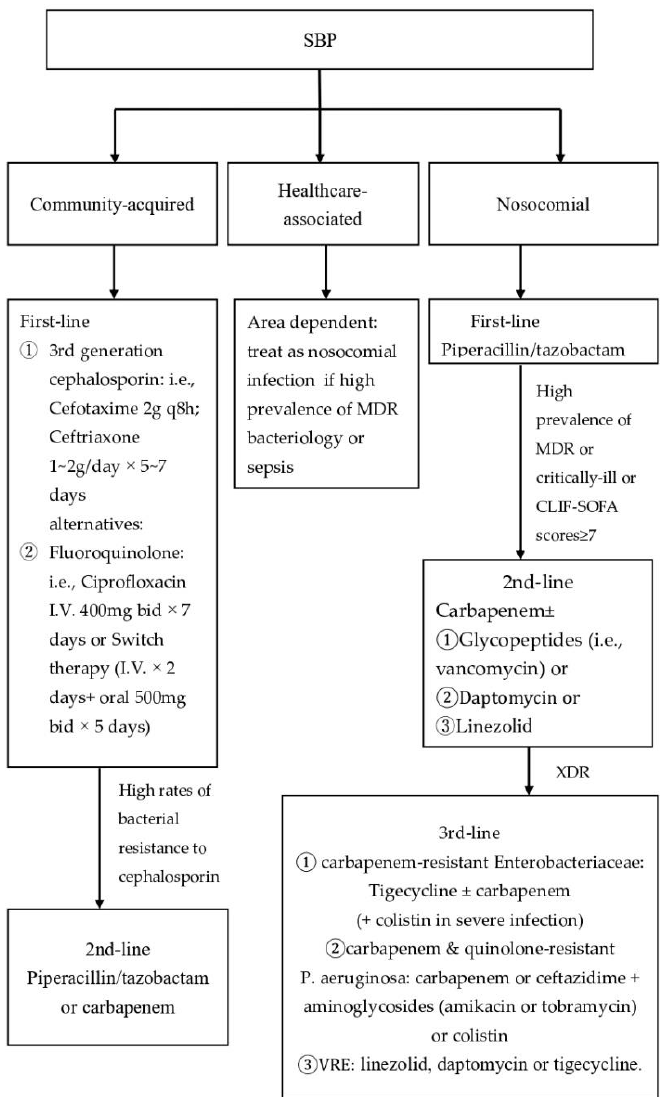
Figure 2. Recommended antibiotic treatment strategy for SBP since